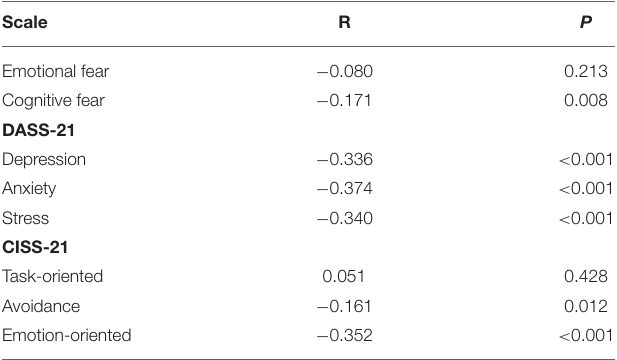
Figure 1 ): • DASS-21 stress, DASS-21 anxiety, and DASS-21